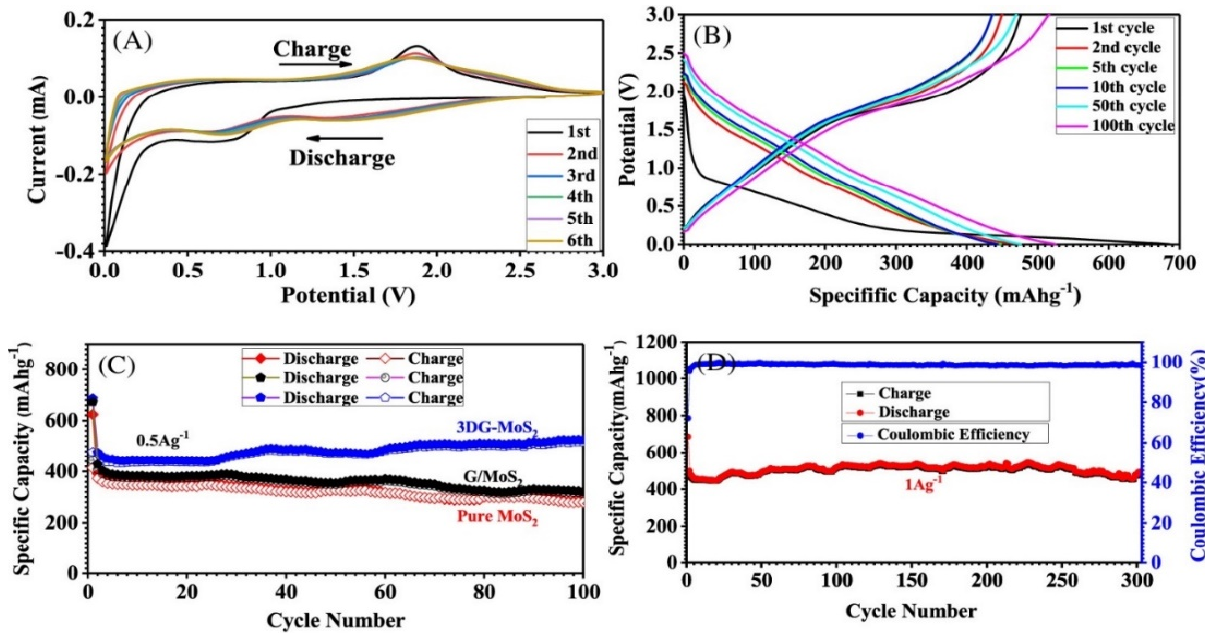
Figure 23. ( A ) CV curves of the 3DG-MoS 2 electrode at the voltage range of 0.0 to 3.0 V versus Na/Na + under the scan rate of 0.5 mVs − 1 ; ( B ) GCD curves of the 3DG-MoS 2 electrode at 0.5 A g − 1 under different cycles; ( C ) Charge/discharge capacities comparison among 3DG-MoS 2 , MoS 2 nanosheets and G/MoS 2 at 0.5 A g − 1 ; ( D ) Charge/discharge capacities and Coulomb efficiency of the 3DG-MoS 2 electrode at 1 A g − 1 . Reproduced with permission [30]. Copyright 2020, John Wiley and Sons.